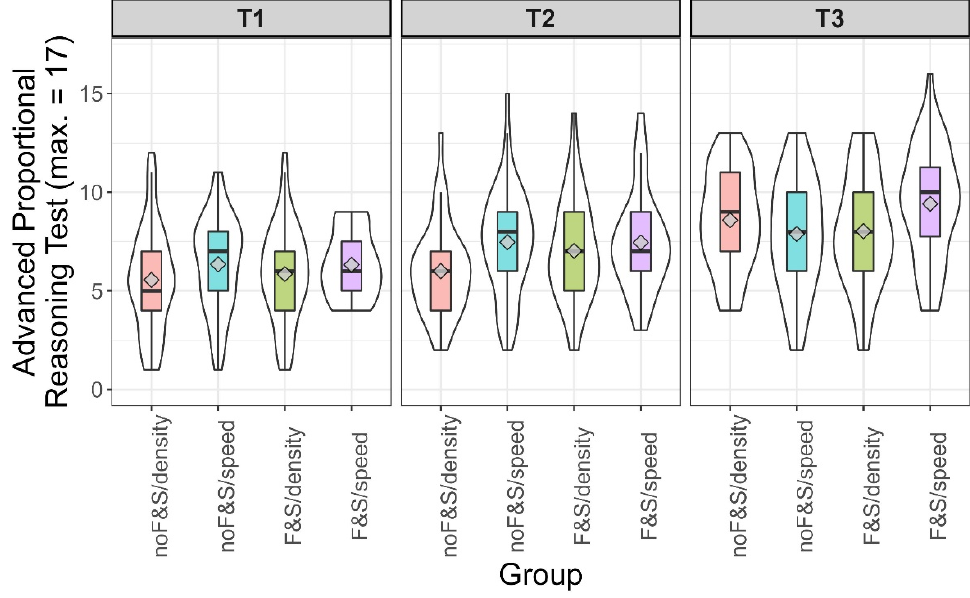
Figure 5. Score on the advanced proportional reasoning test by intelligence tercile and group in Study 2. Violin plots (white) and boxplots (colored). The diamond depicts the mean value per group.